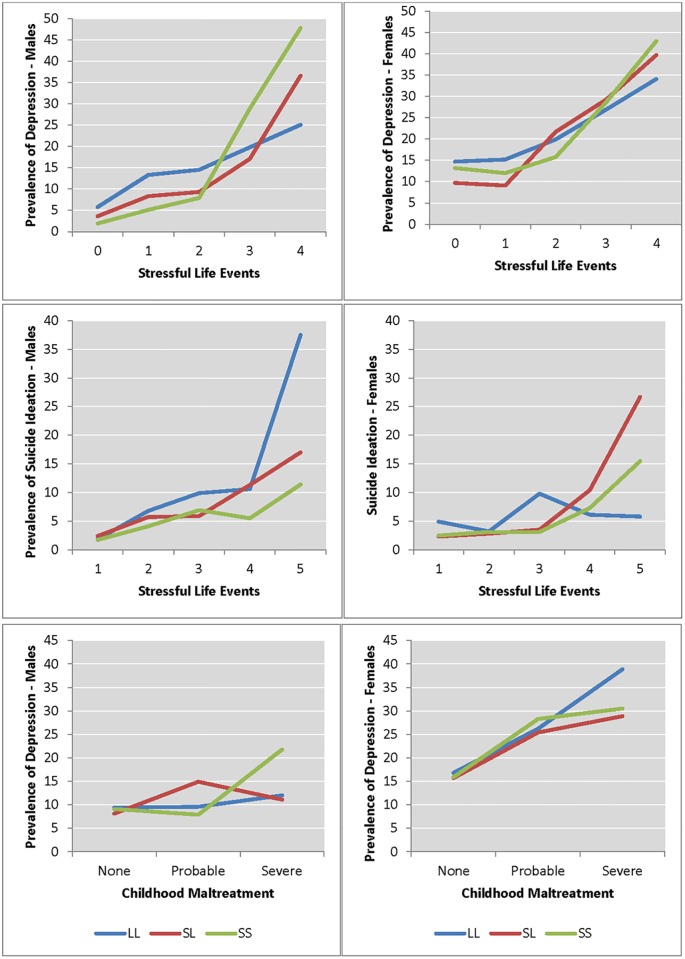
Prevalence Rates for Depression as a function of 5-HTTLPR’ genotype status, two stressful environmental experiences and suicide ideation among young adult males and females.Figs A and B (Top Row) graphically illustrate the prevalence of depression as a function of stressful life events; Figs C and D (Middle Row) illustrate the prevalence depression as a function of suicide ideation; and Figs E and F (Bottom Row) illustrate the prevalence of depression as a function of childhood maltreatment experiences.